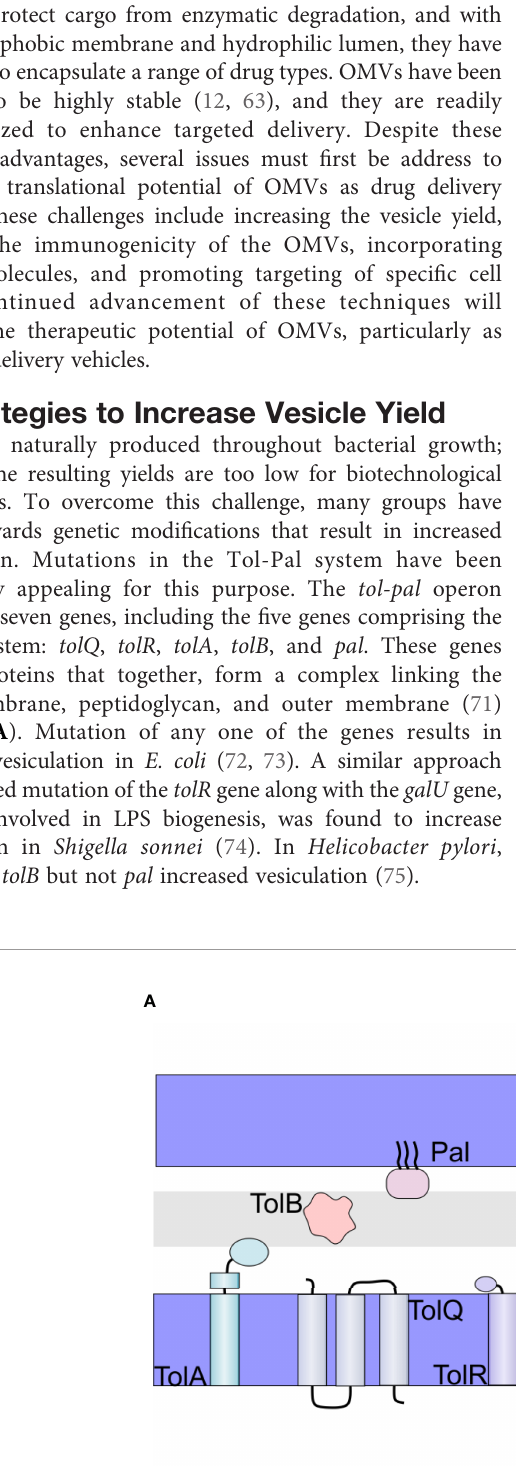
FIGURE 3 | Engineered OMVs. (A) The Tol-Pal System. The Tol-Pal system consists of fi ve proteins, TolA, TolQ, and TolR located in the inner membrane (IM), TolB located in the peptidoglycan layer, and Pal located in the outer membrane. Mutation of any of these components has been shown to affect vesiculation. (B) Structure of LPS. LPS consists of a hydrophobic lipid A, which is commonly hexaacylated and di-phosphorylated (P). The polysaccharide portion of the molecule consists of a well conserved inner and outer core and a nonconserved